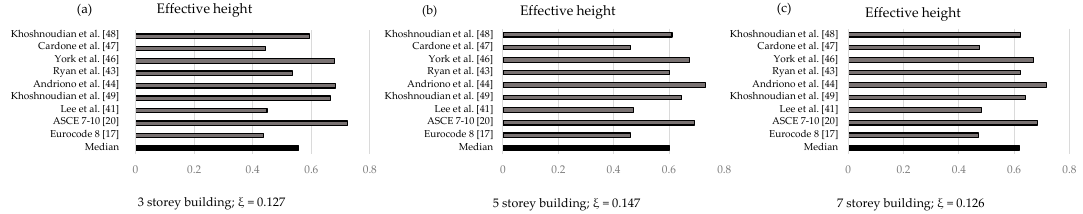
Figure 10. Effective height of the different lateral distribution of shear force available in literature for three different base-isolated configurations: three-story ( a ), five-story ( b ) and seven-story building ( c ).